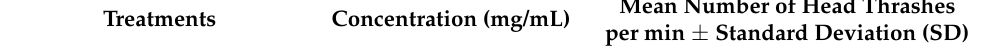
Table 5. The egg-laying activity of LL extract and mimosine. Treatments